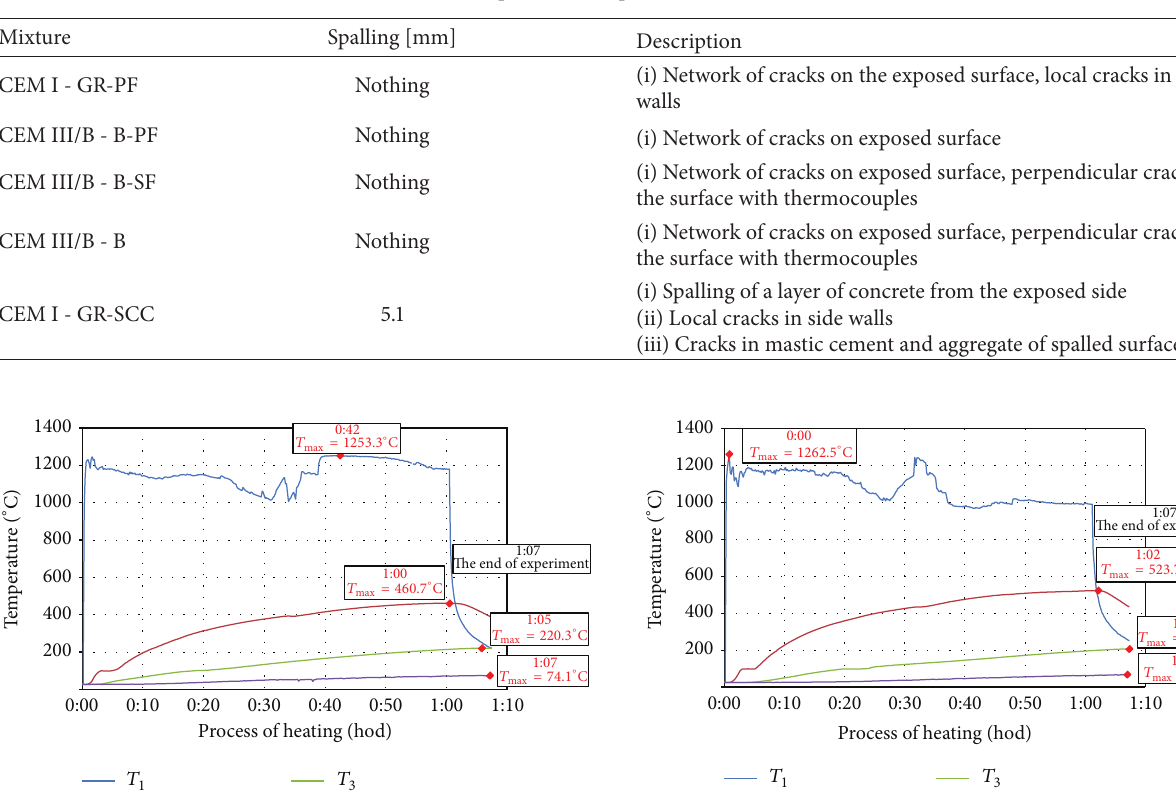
Table 5: Description of test specimens after thermal load.